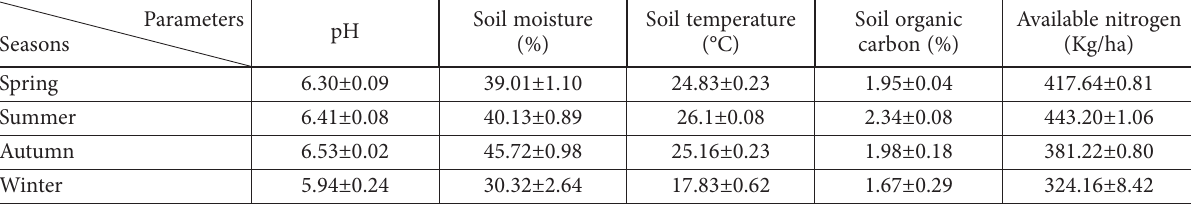
Table 2. Seasonal variation in physico-chemical characteristics of soil at SCS